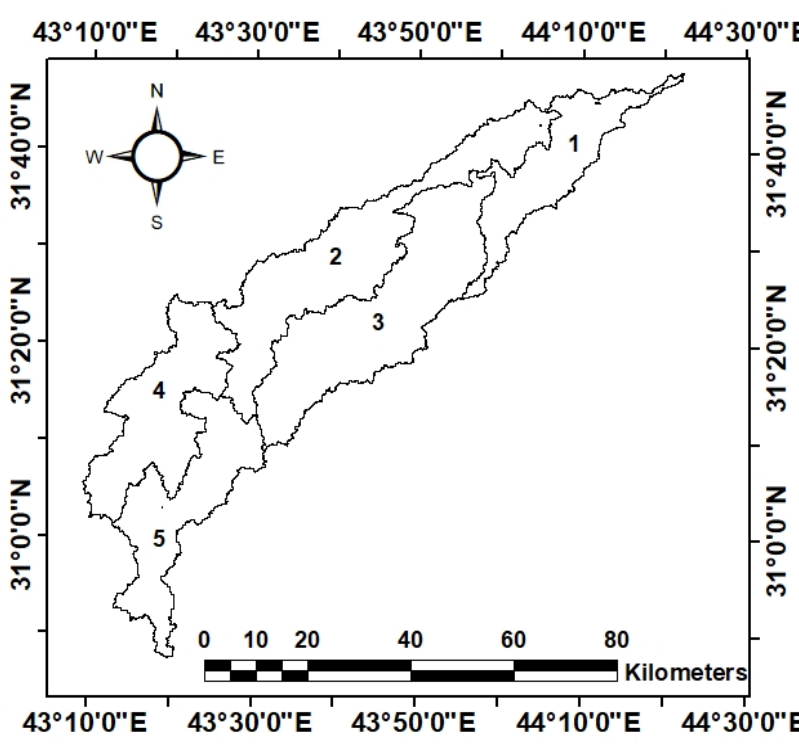
Fig. 11. The sub-basins of basin